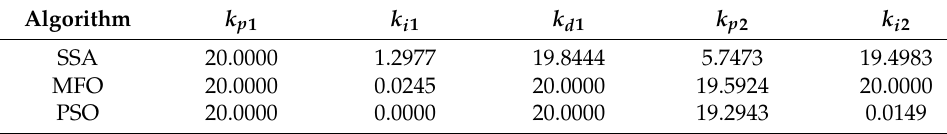
Figure 8. Convergence rate curve of the fitness of angular displacement during the optimization process, ( a ) optimize the cascade PID controller, ( b ) optimize the fuzzy adaptive PID controller. Table 4. Parameters factor optimization results of fuzzy controller.